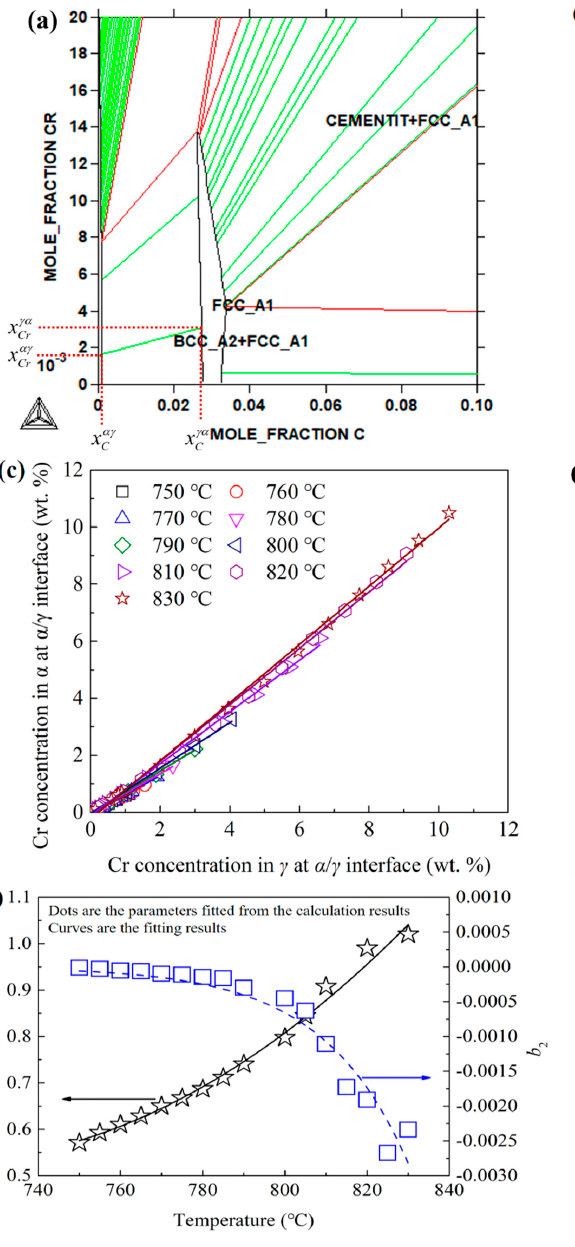
Figure 3. The thermodynamic equilibrium data for Fe-C-Cr system calculated with Thermo-Calc software. ( a ) Equilibrium phase diagram for ferrite and austenite at 750 °C; ( b ) relationships between the C and Cr concentrations in austenite at the γ / α interface at different temperatures; ( c ) the relationships between the Cr concentrations in ferrite and austenite at the γ / α interface at different temperatures; ( d ) relationship between b 1 (in Equation (13)) and temperature; ( e ) relationships between a 2 and b 2 (in Equation (14)) and temperature; ( f ) relationship between the interfacial C concentration in ferrite and